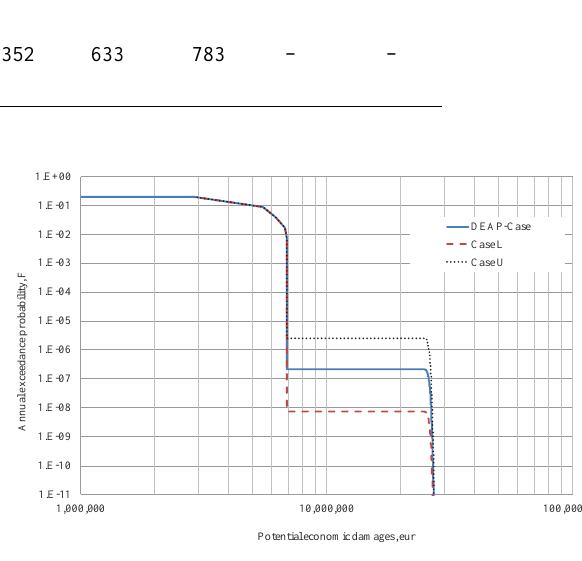
Fig. 13. FN-curves for the DEAP-Case and sensitivity analysis.